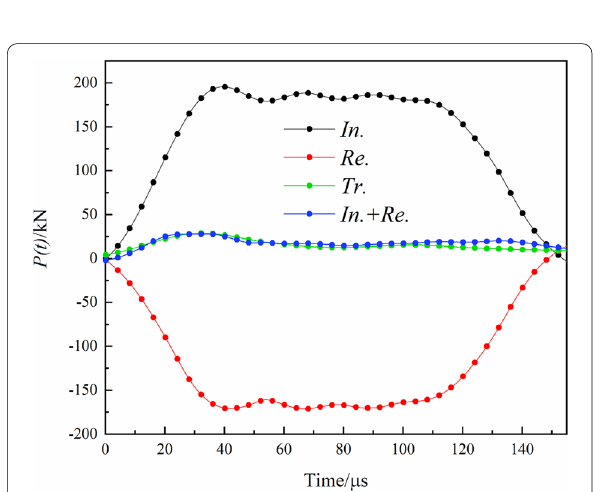
Fig. 4 Verification of force balance for a typical specimen